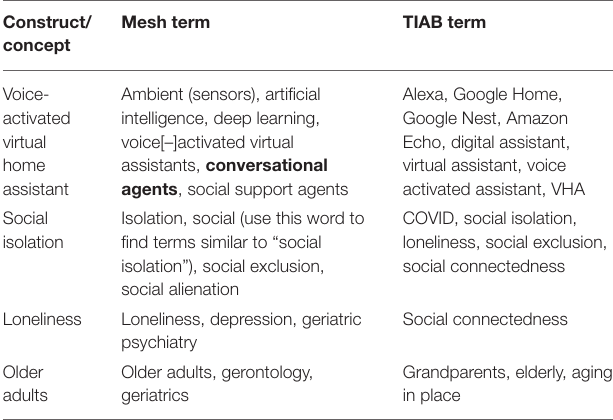
TABLE 1 | Concepts with MeSH and TIAB terms used for PubMed